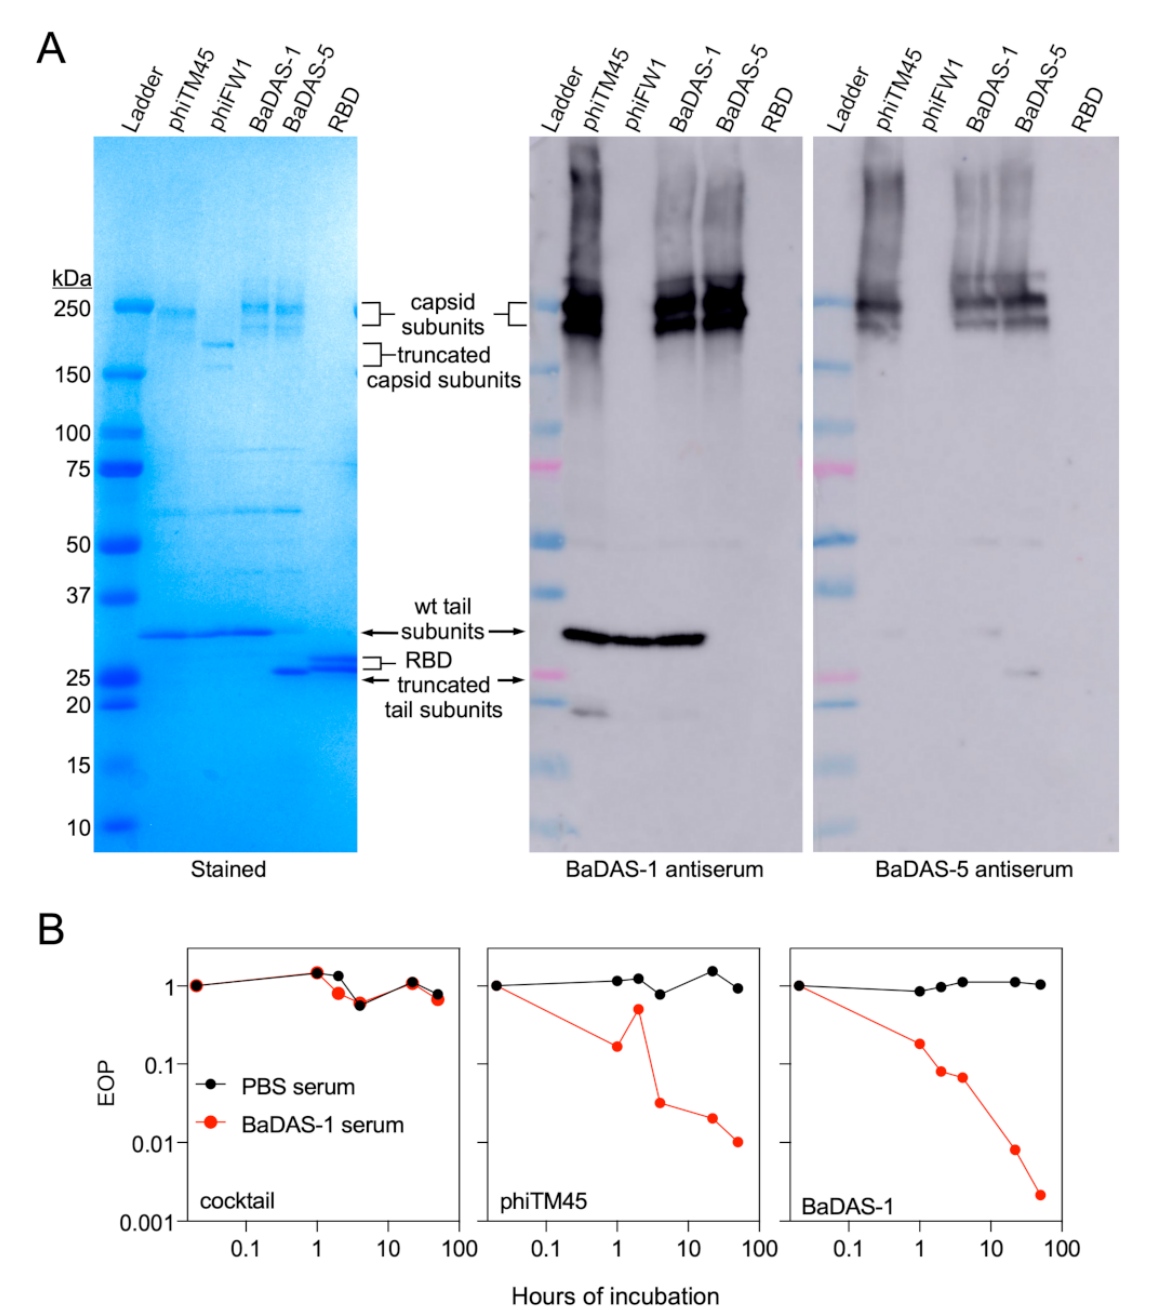
Figure 6. Native C-terminal extensions of Bxb1 capsid and tail proteins are immunodominant. ( A ) Coomassie-stained gel (left) and Western blots (right) of wild type phiTM45 and mutants phiFW1, BaDAS-1, and BaDAS-5, as well as recombinant SARS-CoV-2 RBD. When probed with serum from a mouse immunized with BaDAS-1, strong binding to wild type tail proteins is observed. In contrast, serum from a mouse immunized with the shaved-tail derivative, BaDAS-5, produces little to no binding to tail proteins. Robust binding to the capsid protein complexes of phiTM45, BaDAS-1 and BaDAS-5 is observed for both sera, while neither sera binds to the truncated capsid proteins of phiFW1. No binding to the SARS-CoV-2 RBD is observed from either sera, despite the presence of significant spike-binding antibodies as assayed by ELISA; this is due to the substantially stronger immune response to phage structural components compared to the display SARS-CoV-2 antigens. Western blots probing response to RBD only are shown in Figure S2. ( B ) A cocktail of unrelated phages, wild type phiTM45, and BaDAS-1 were incubated with sera from mice immunized with PBS or BaDAS-1 and, after the specified duration of incubation, titered. While the cocktail of unrelated phages were unaffected by this treatment, both phiTM45 and BaDAS-1 were substantially neutralized by the BaDAS-1 antiserum (but unaffected by the mock infection